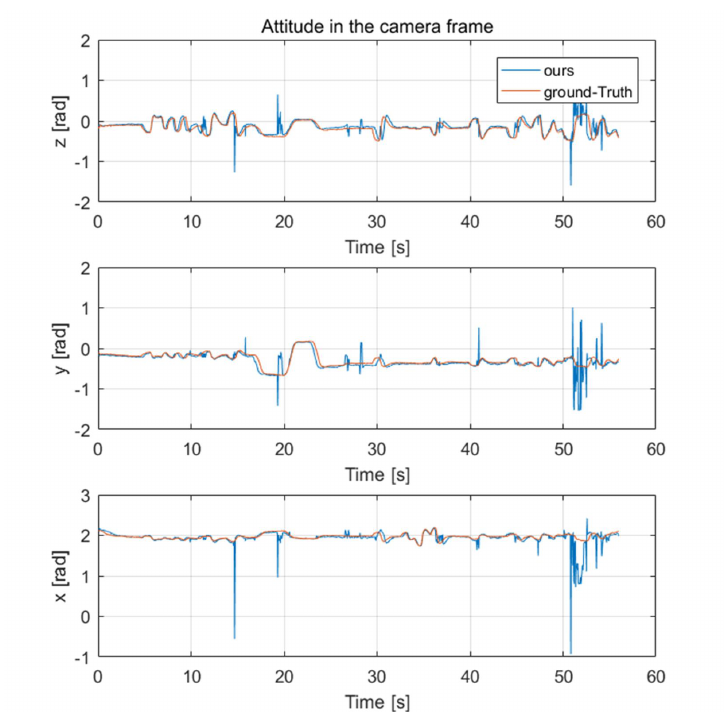
Figure 8. The attitude estimation in the camera frame, compared with OptiTrack (as